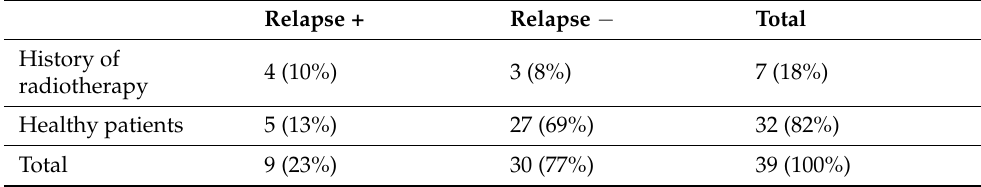
Table 5. Crosstabulation for the impact of radiotherapy on relapse occurrence. Relapse